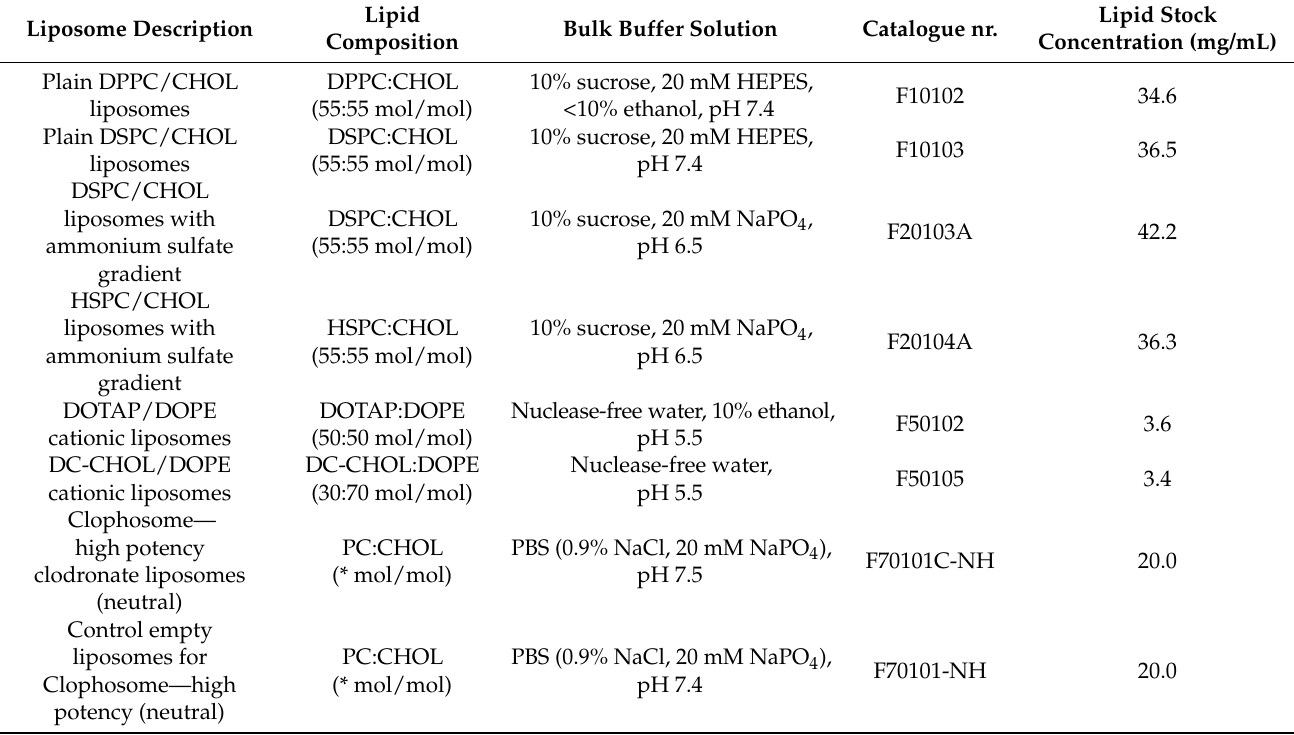
Table 1. List of liposomes used in the study.